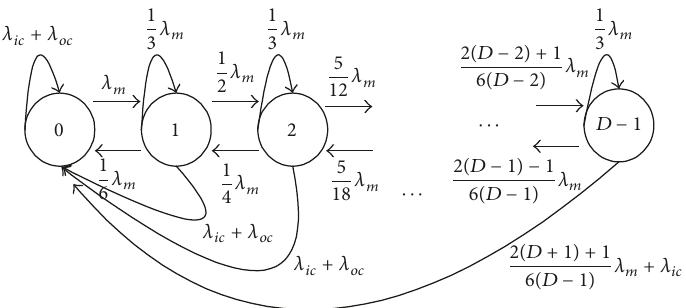
Figure 2: State-transition diagram of the DBIR scheme using CTMC.